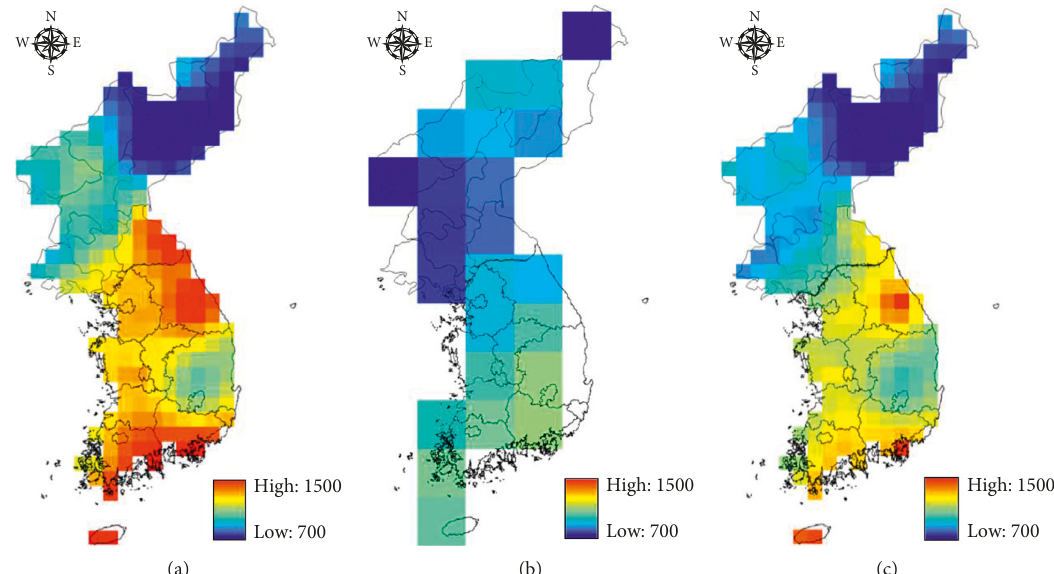
Figure 5: Spatial distribution for observation and before and after downscaling (annual precipitation). (a) OBS. (b) Raw scenario. (c) Downscaled scenario.